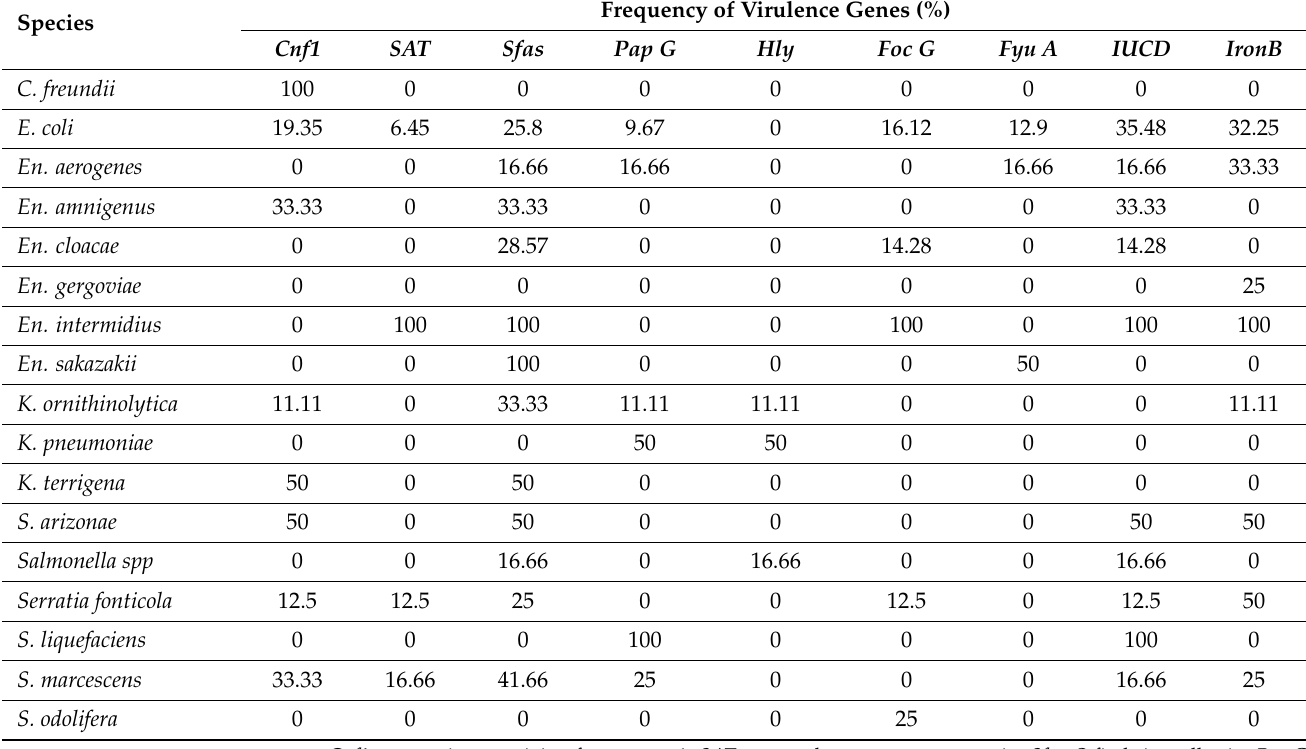
Table 4. Proportion of genes recorded by species.